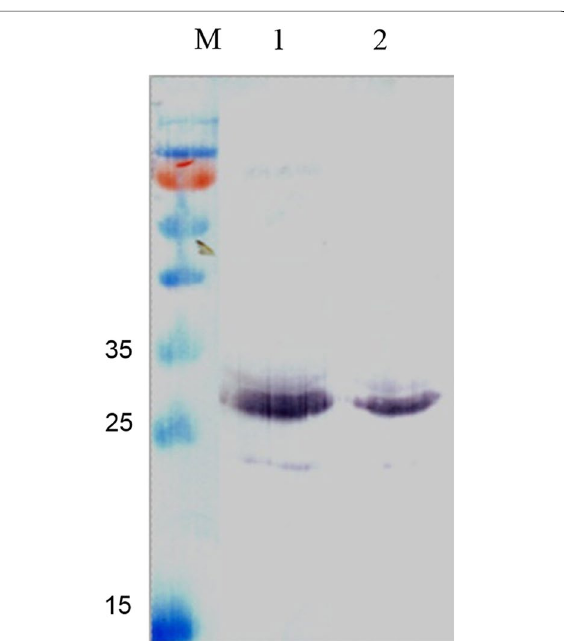
Fig. 7 Lane 1, Immunoblotting of the outer membrane fraction without treatment with sortase. Lanes 2, immunoblotting of the outer membrane fraction after treatment with sortase. There is a significant decrease in the density of chimeric protein on the outer